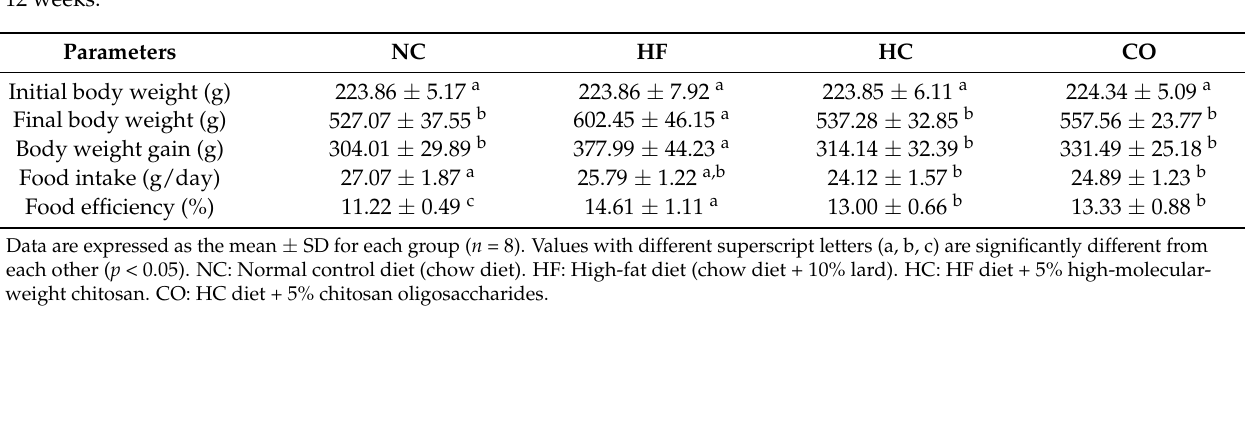
Table 1. The changes in body weight, food intake, and food utilization rate in rats fed with different experimental diets for 12 weeks.